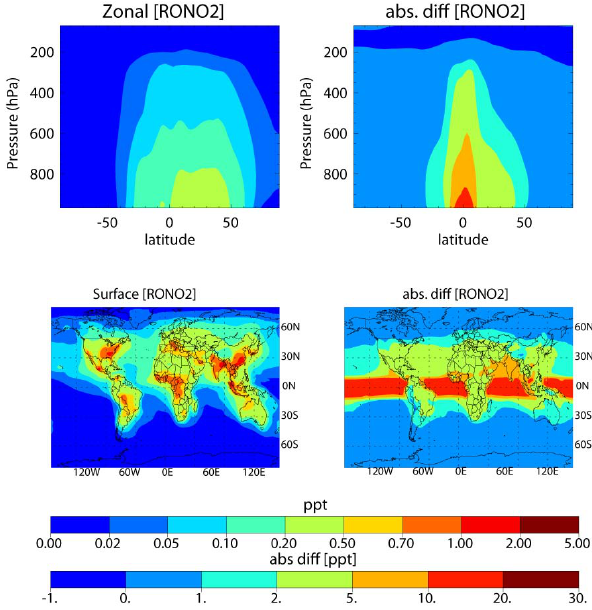
Fig. 4. The annual global distribution in RONO 2 during 2008 given in ppb. Both the zonal and horizontal (<800hPa) means are shown (top and bottom, respectively) for the BASE simulation. The abso- lute differences when compared against the FULL simulation are also given, with differences being in the ppt